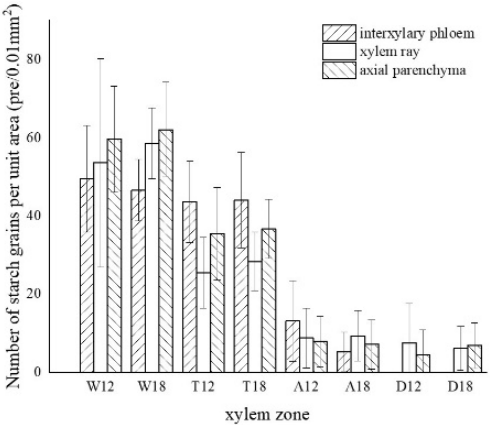
Figure 7. Statistics of color development of starch grains in parenchyma cells. W—white zone; T— transition zone; A—agarwood zone; D—decay zone; 12—inoculated for 12 months; 18—inoculated for 18 months.